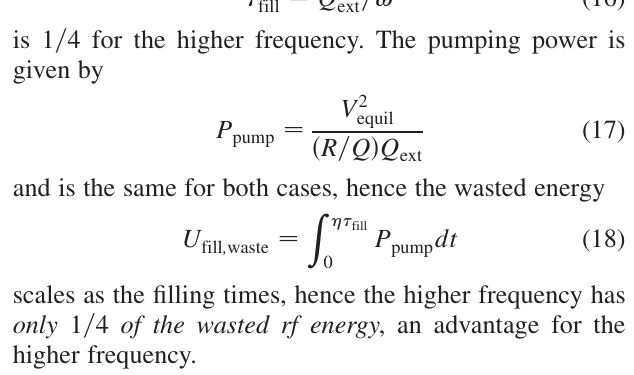
cycles: (1) LP-SPL : the maximum ratings from Table II: 4 GeV, 1.2 ms, 20 mA, 2 Hz ) cryoduty cycle of 0 : 41% = 0 : 28% (including the filling and decay time in the SC cavities at 704 : 4 = 1408 : 8 MHz ); (2) HP-SPL ‘‘neu- trino’’ : the ratings for neutrino operation from Table III: 5 GeV, 0.4 ms, 40 mA, 50 Hz ) cryoduty cycle of (cid:1) 4 : 1% = 2 : 5% (including the filling and decay time in